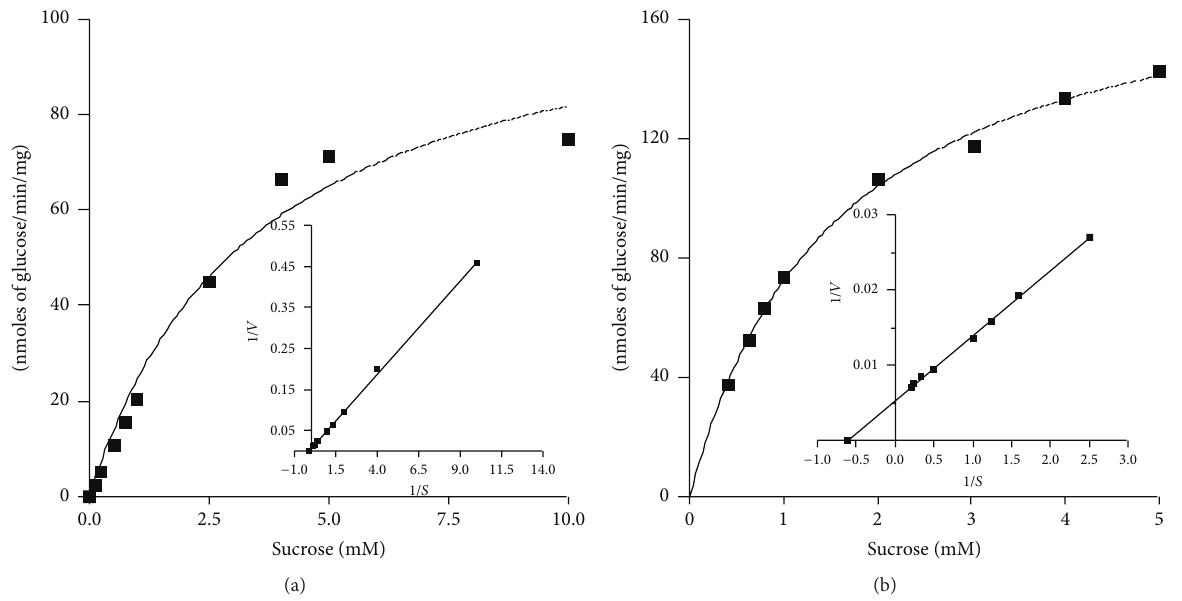
Figure 3: Enzyme kinetics of crude and purified intracellular sucrase: intracellular sucrase was incubated in the assay mixture with varying range of substrate concentration (0.20–10 mM) at a fixed incubation time to estimate the enzyme activity of crude (a) and purified (b) intracellular sucrase. The inset represents the Lineweaver-Burk plot of velocity and substrate concentration of crude and purified intracellular sucrase which shows 𝐾 𝑚 of 6.6 mM and 1.61 mM of sucrose, respectively. The results are the mean of three independent experiments ( 𝑛 = 3